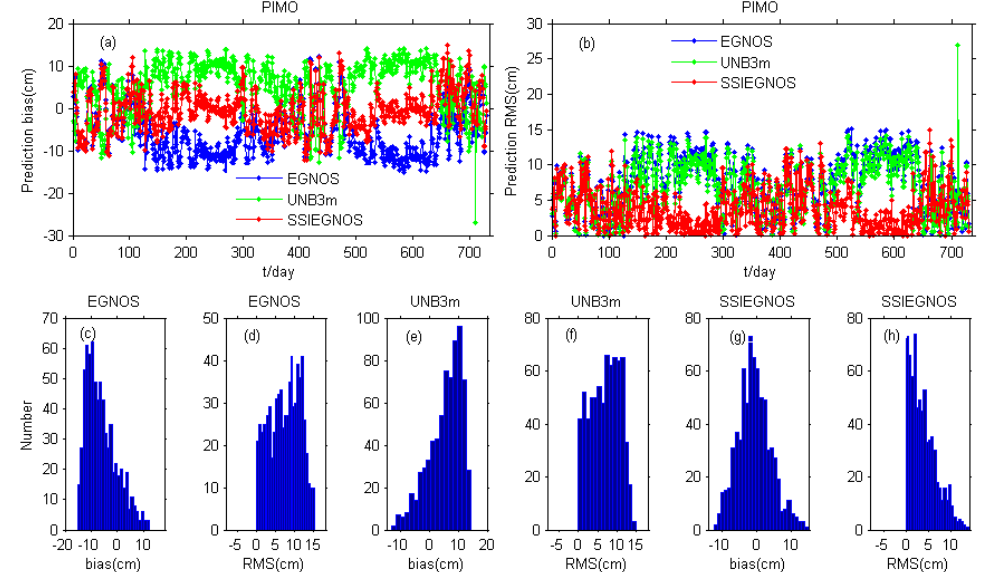
Figure 13. ( a , b ) Time series of daily predicted bias and RMS error from 2011–2012 at the PIMO site. The blue line denotes the EGNOS model, the green line denotes the UNB3m model, and the red line denotes the SSIEGNOS model. ( c – h ) Histograms of the daily predicted bias and RMS error from 2011–2012 for the three models.